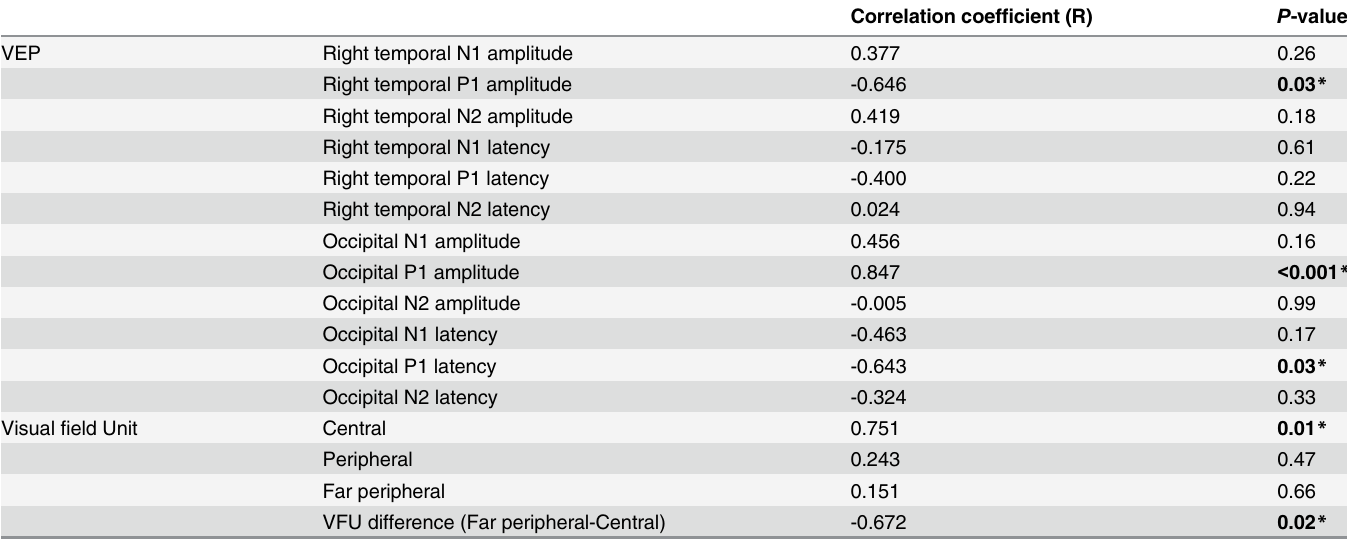
Age, duration of deafness, duration of CI use and implant site were adjusted by partial correlation